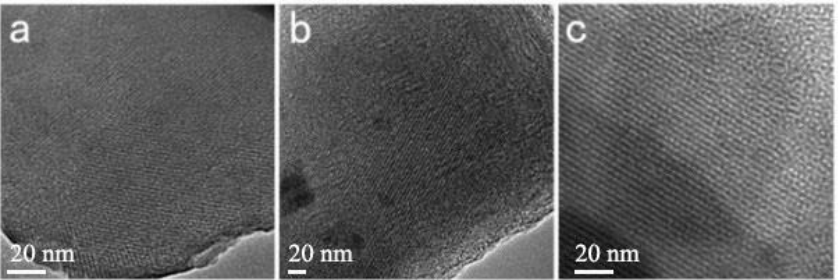
Figure 10. TEM images of the samples. ( a ) Mesoporous material synthesized with Gemini ionic liquid surfactant [N 1116 C 3 IMC 16 ][Br] 2 as template; ( b ) Mesoporous material synthesized with Gemini ionic